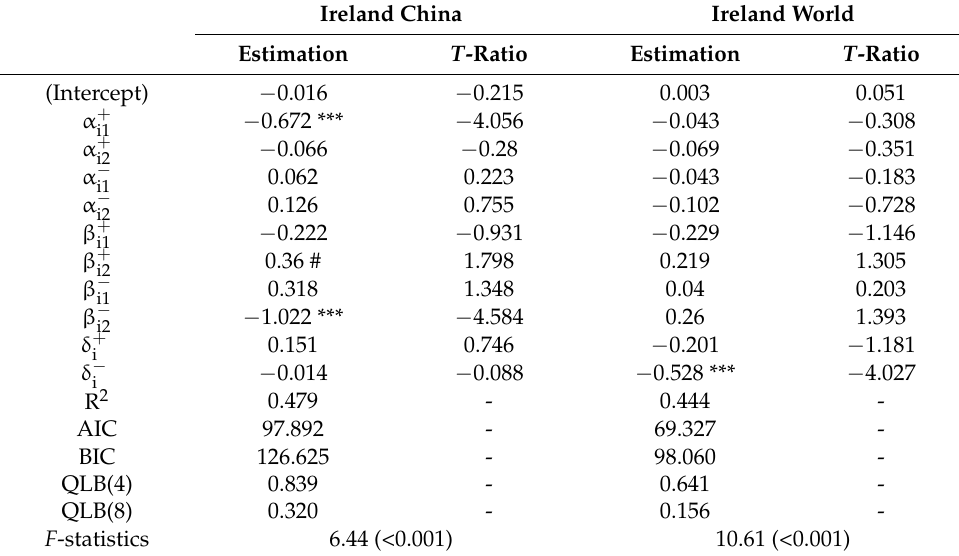
Table 4. Results of the asymmetric error correction model with threshold cointegration for